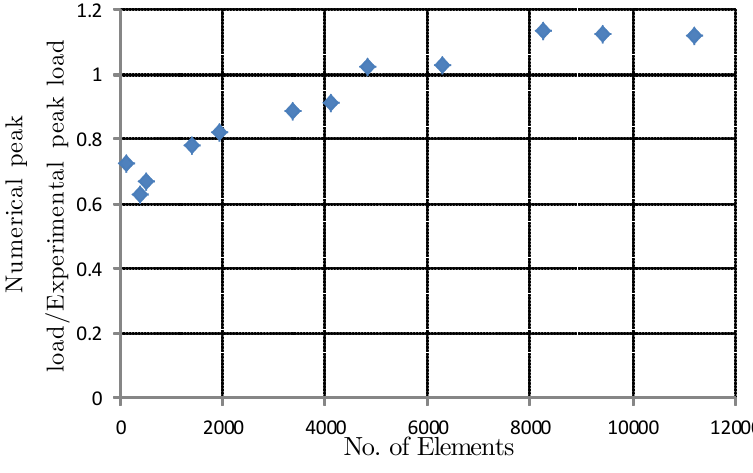
Figure 4. Mesh sensitivity analysis.